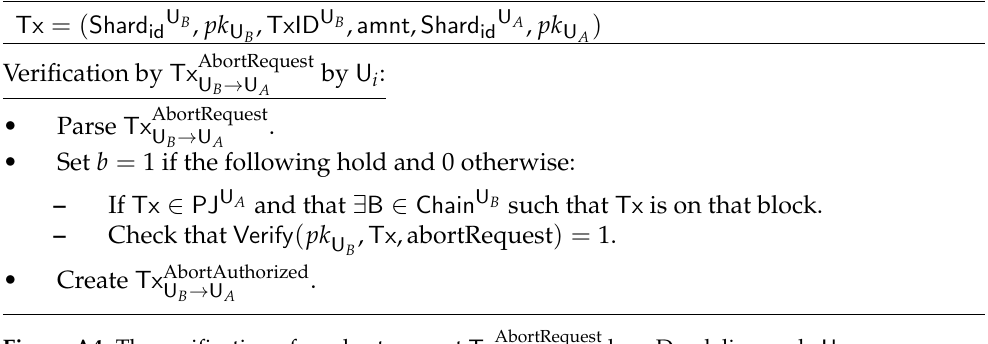
Figure A4. The verification of an abort request Tx AbortRequest